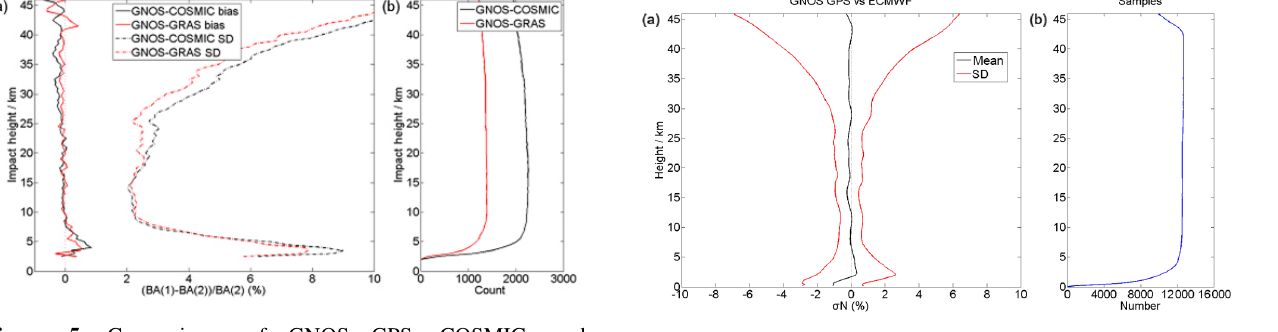
Figure 6. Refractivity deviation from the ECMWF analysis for FY- 3C GNOS GPS (from 1 November to 31 December 2013). The left panel shows the mean bias (black) and the standard deviation (red), and the right panel shows the samples used vs. altitude (source: Liao et al., 2016b).